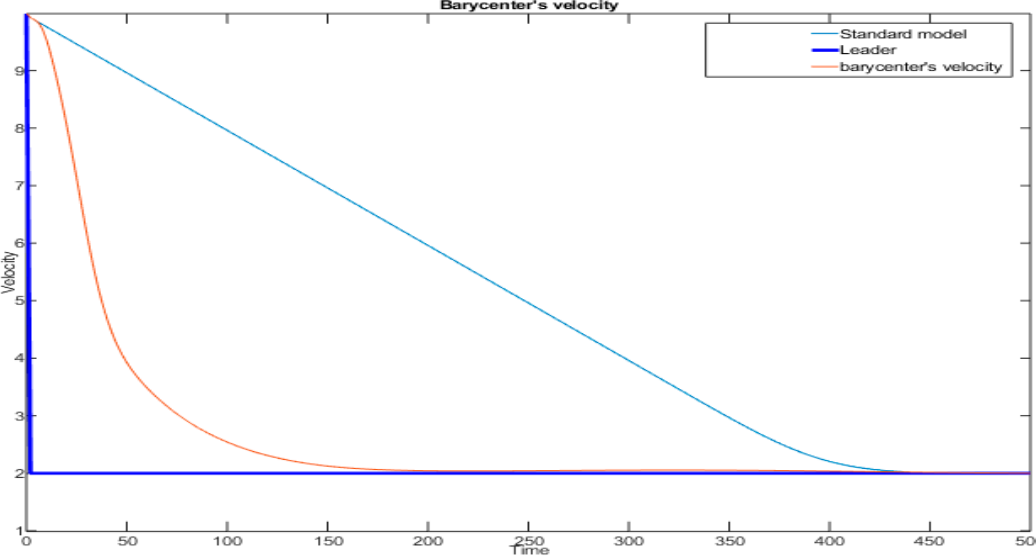
Figure 20. Comparison between the barycenter’s velocity for the standard and small-world model, for the braking maneuver imparted to the leader Equation (15), as in Figure 10; Figure 12.